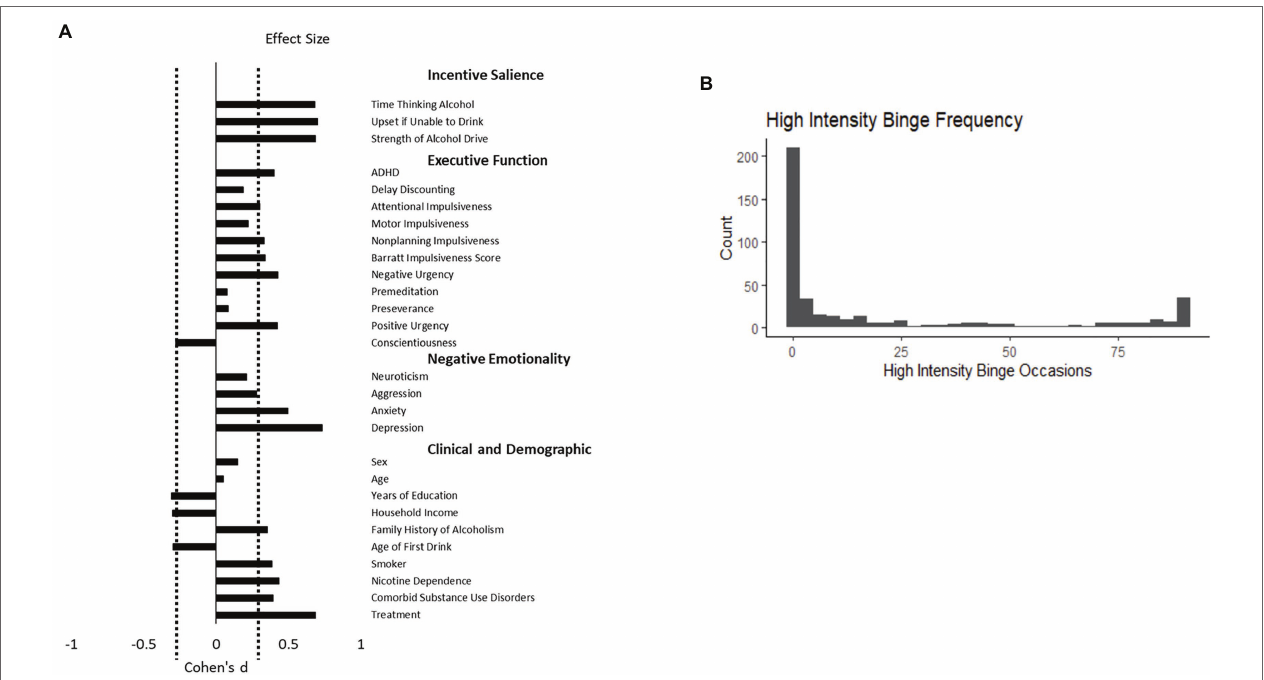
FIGURE 1 | (A) depicts the effect size of the group difference between adults with alcohol use disorder who engaged in high-intensity binge drinking behavior relative to those who did not. Attentional, Motor, and Nonplanning Impulsiveness are subscales of the Barratt Impulsiveness Scale. Delay discounting is the natural log of the k discounting constant. The three incentive salience measures represent questions 1, 11, and 13 from the Obsessive–Compulsive Dependence Scale. Positive values indicate that the group that engaged in high-intensity binge drinking had greater values of the measure. The dashed line represents a significant difference at a false discovery rate corrected value of p <0.05. (B) depicts the frequency of each value high-intensity binge occasions across 90 days in this sample of 429 adults with alcohol use